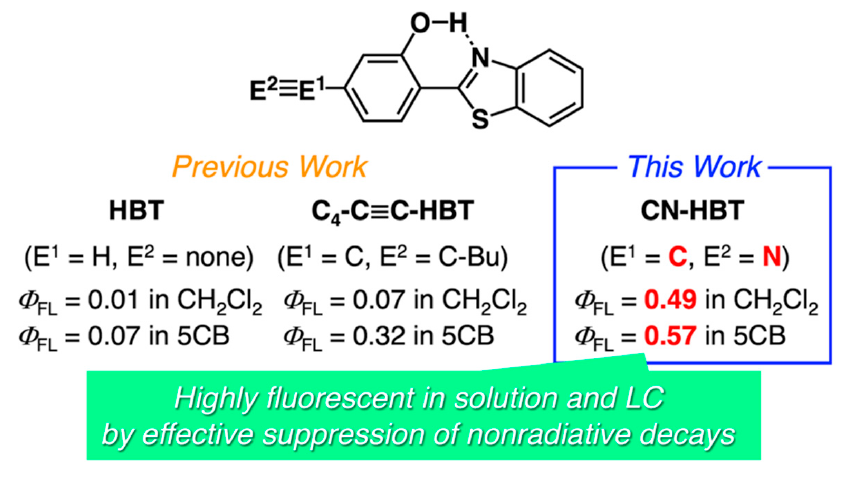
Figure 2. Molecular design of highly fluorescent HBT derivatives.